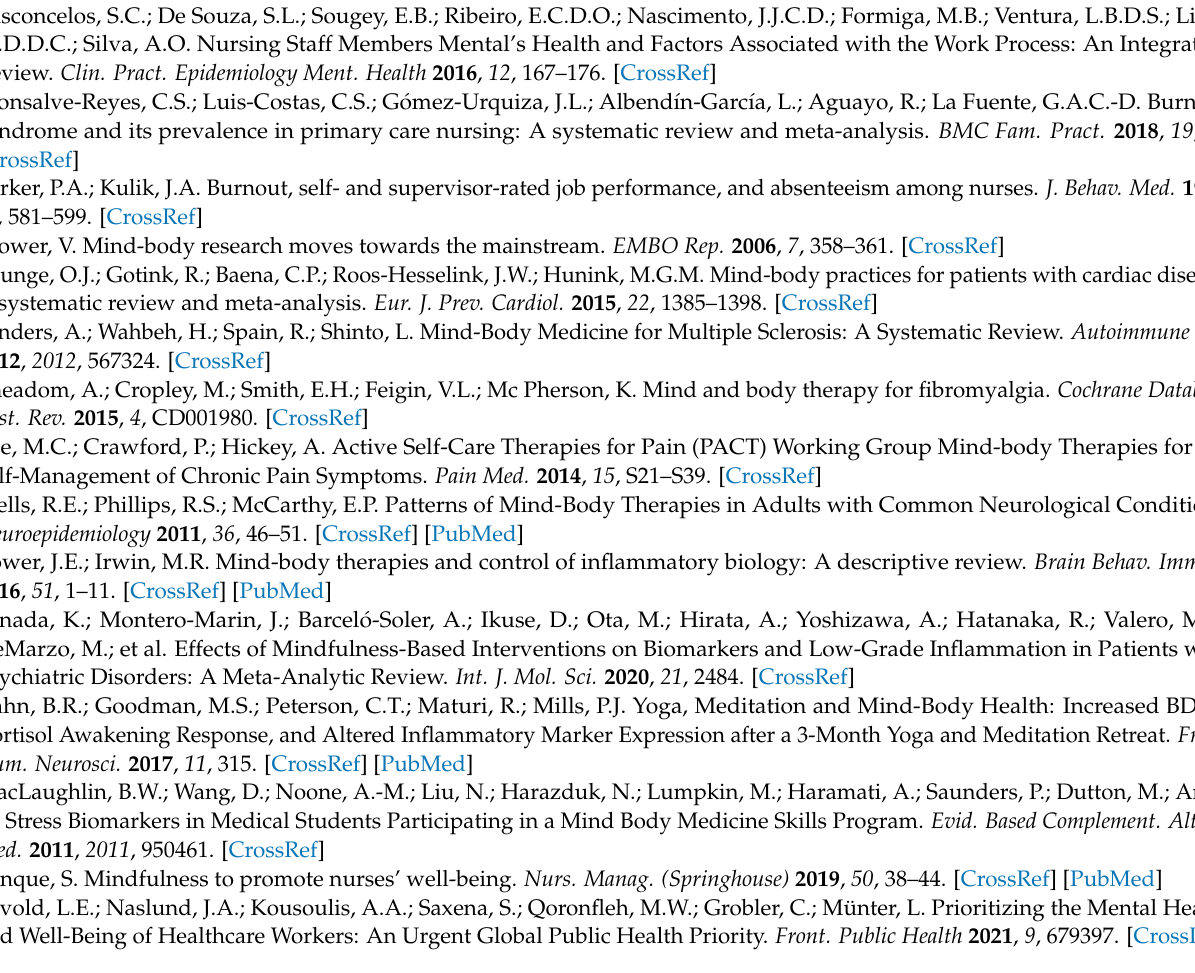
Table S2: Supplementary Digital Content 2. Search strategies used in each